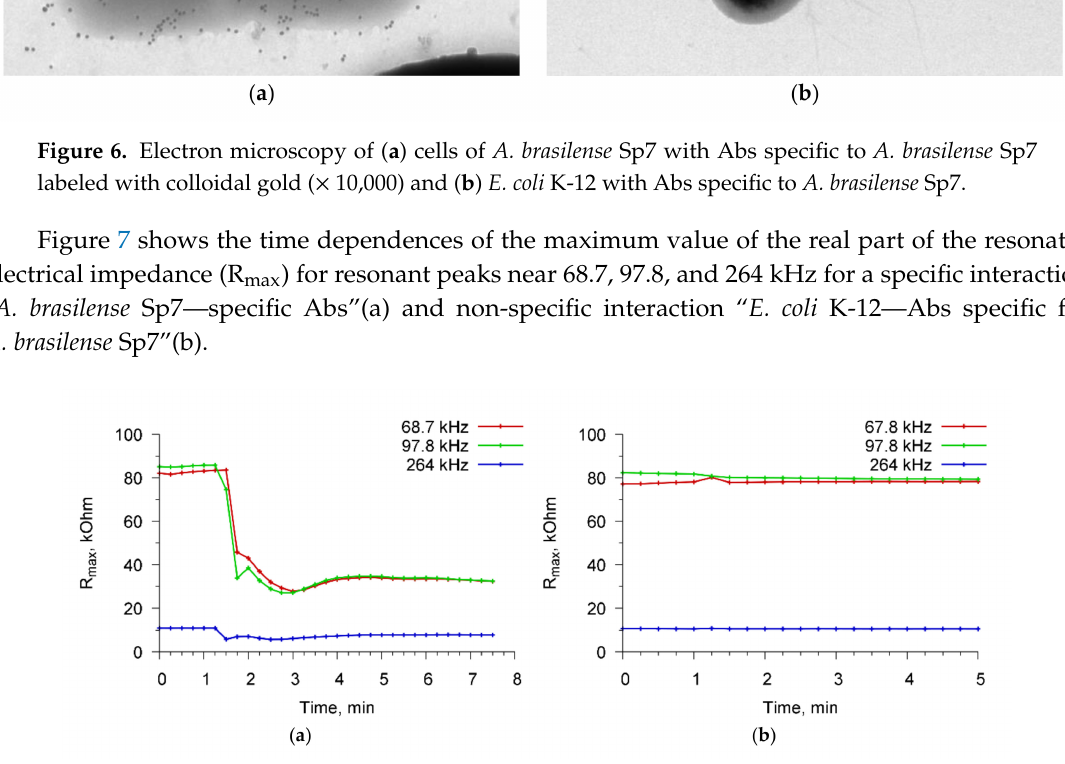
Figure 7. The time dependencies of the maximum of real part of the electrical impedance of PZT resonator during a specific interaction “ A. brasilense Sp7—specific Abs” ( a ) and nonspecific interaction “ E. coli K-12—Abs specific to A. brasilense Sp7 ( b ), for resonance peaks near frequencies 68.7, 97.8, and 264